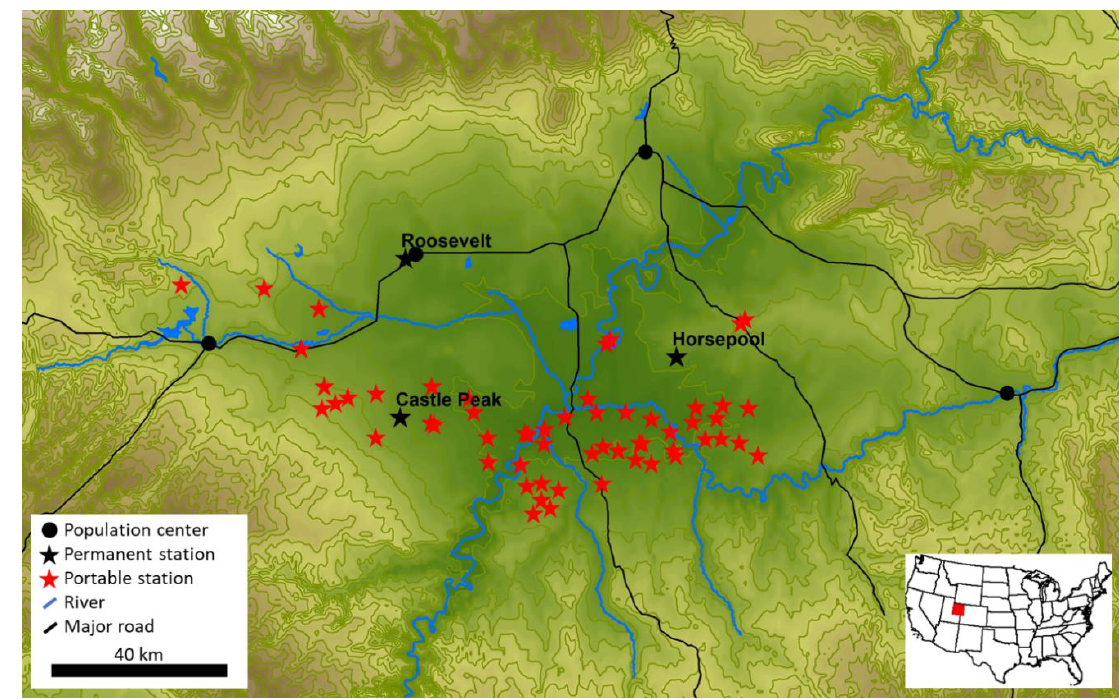
Figure 1. Map of the Uinta Basin, with all sampling stations shown. Portable station locations shown are locations where at least one measurement occurred. Elevation contours are at 100 m intervals. For reference, the Horsepool station is at 1569 m.